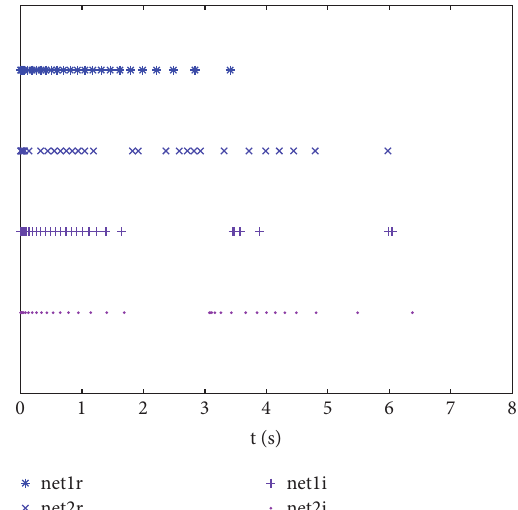
Figure 5: The event-triggered time instants t i mean the real-valued parts of the slave networks 1 and 2. net1i and net2i represent the imaginary parts of the slave networks 1 and 2,